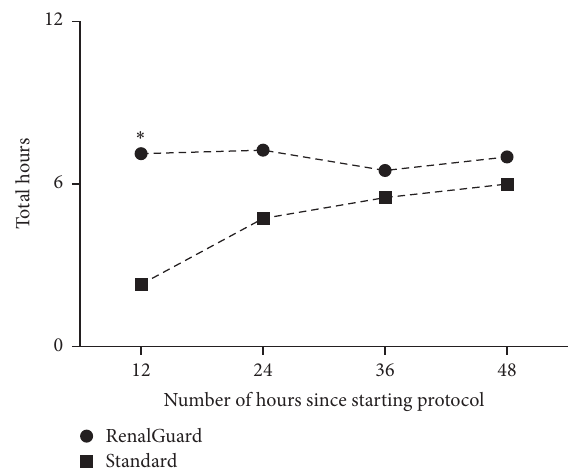
Figure 2: The number of hours of urine output > 2 mL/kg in each 12 hours of treatment ( ∗ 𝑝 < 0.01) .